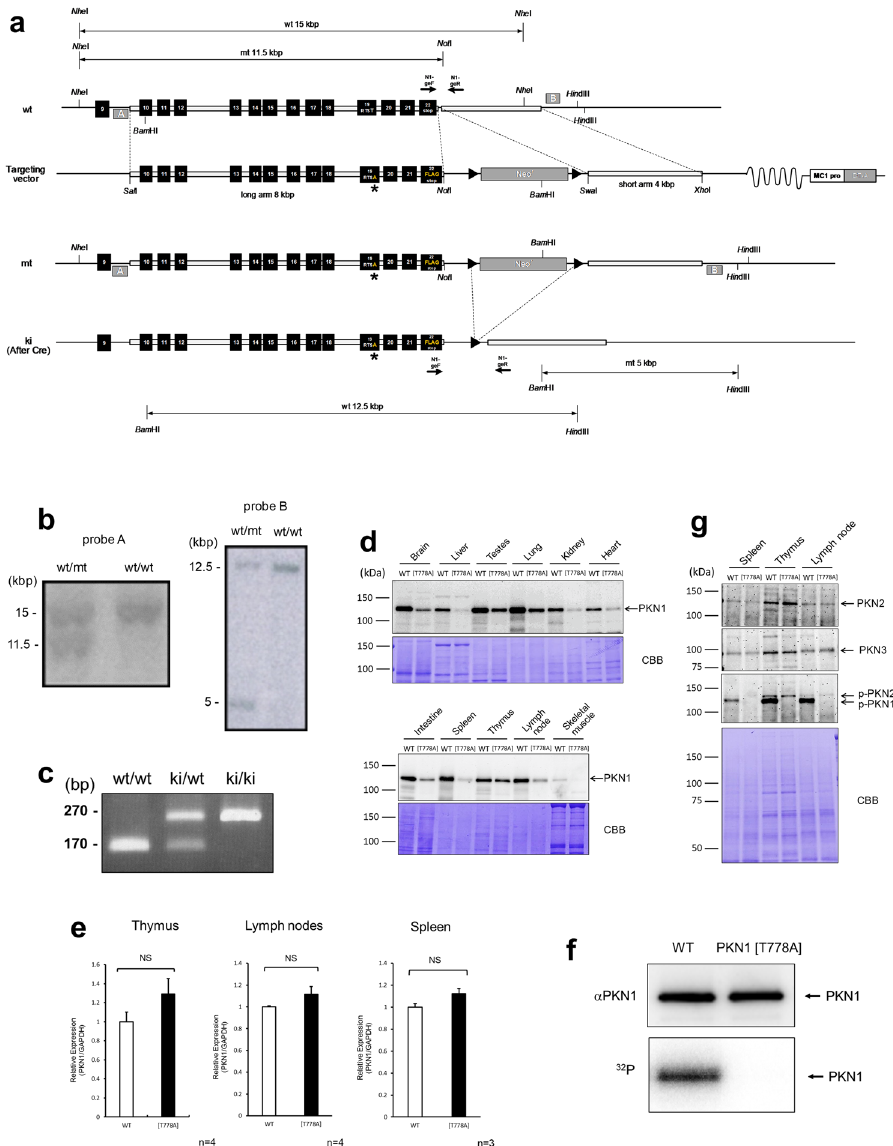
Figure 1. Generation of PKN1[T778A] mice. ( a ) Schematic diagram of the PKN1 genomic DNA, targeting vector, and disrupted gene. The targeting vector and a partial map of PKN1 locus before (wt) and after (mt) homologous recombination in embryonic stem cells, and after further deletion of the neomycin resistance cassette (ki) by Cre-mediated recombination. Positions of loxP sites are designated by black triangles. Crosses with heterozygous mice generated homozygous PKN1 kinase-negative knock-in (PKN1[T778A]) mice. Exons are denoted by black boxes. Positions of the genomic DNA probes (A and B) used for Southern blotting and the primers used for discrimination between wt and ki (N1-geF and N1-geR) are indicated. A, probe A; B, probe B; Cre, P1 bacteriophage cyclization recombination; loxP, locus of X-over in P1; E, exon; Neo r , neomycin- resistance gene; MC1 pro, MC1 promoter; DT-A, Diphtheria toxin A; * , T778A mutation. ( b ) Southern blot results for representative littermates (F2 mice) obtained by crossing F1 mice with WT mice are shown. Genomic DNA of F2 mice was digested with Nhe I and Not I, probed with probe A on the left, and digested with Bam HI and Hin dIII, probed with probe B on the right. ( c ) PCR genotyping. Representative results are shown for discrimination between wt and ki allele (lacking the Neo cassette). ( d ) Whole-cell lysates of each tissue from WT and PKN1[T778A] mice were resolved by SDS-PAGE and subjected to immunoblot analyses using α C6 for PKN1 detection. Coomassie Brilliant Blue (CBB)-stained PVDF membrane is shown (lower panel). ( e ) PKN1 expression in the thymus, lymph nodes, and spleen of WT and PKN1[T778A] mice was measured by RT-qPCR. Data represent fold changes in PKN1 gene expression in [T778A] mice normalized to GAPDH relative to expression in WT mice. Data were analysed with unpaired t -tests. NS, not significant. ( f ) Immunoprecipitation and kinase assay of PKN1. Immunoblotting results using α C6 are shown in the upper panel, and autoradiography results are shown in the lower panel. ( g ) Expression of PKN2 and PKN3, and phosphorylation levels of PKN2 at Thr815 are shown. For raw gel data see Supplementary Fig.